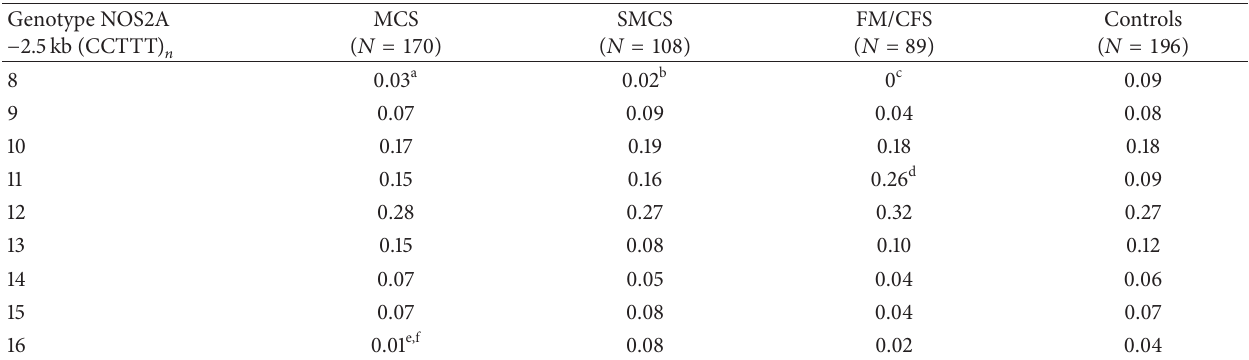
Table 2: Allelic distributions of the NOS2A promoter pentanucleotide microsatellite − 2.5 kb (CCTTT ) 𝑛 in IEI patients and healthy subjects. Genotype NOS2A − 2.5 kb (CCTTT )